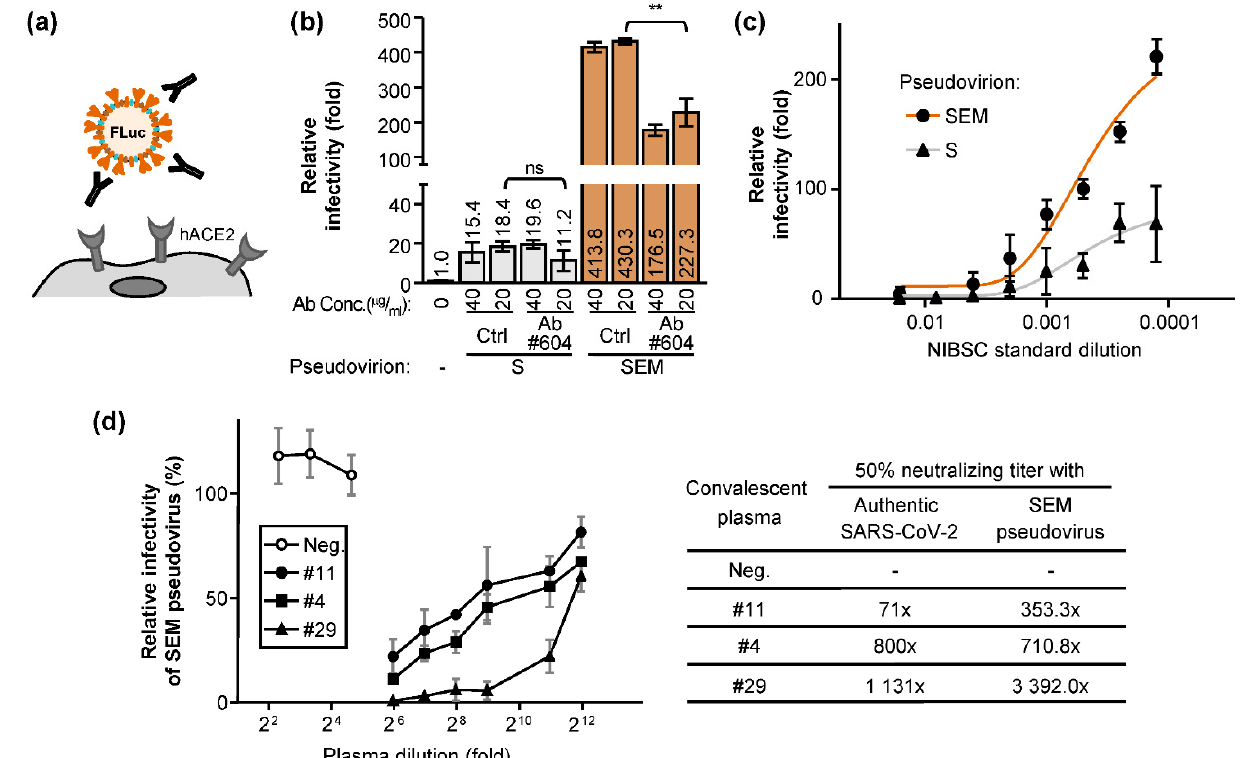
Figure 6. The SEM pseudovirion provides a better assessment window than the S-alone virus in studying SARS-CoV-2 virion entry: ( a ) the pseudovirus neutralization assay is shown in a diagram. ( b , c ) The monoclonal antibody (Ab#604) ( b ) or the standard plasma from the National Institute for Biological Standards and Control (NIBSC) ( c ) were diluted and incubated with pseudovirus for 1 h as indicated. The mixture was then transferred to infect BHK-hACE2 cells for 6 h. Samples were harvested at 48 h post-infection for luciferase activity. Data are mean ± SD ( n = 3 per group). ( d ) Three Taiwanese convalescent plasma were two-fold serially diluted to neutralize the SEM-pseudovirus. The 50% neutralizing titer (NT50) of each sample determined by SEM pseudovirus or by authentic SARS-CoV-2 were summarized (right). Data ( b – d ) are mean ± SD, n = 3 per group, and were compared by two-tailed Student’s t test. ns, no significance; **, p < 0.01.